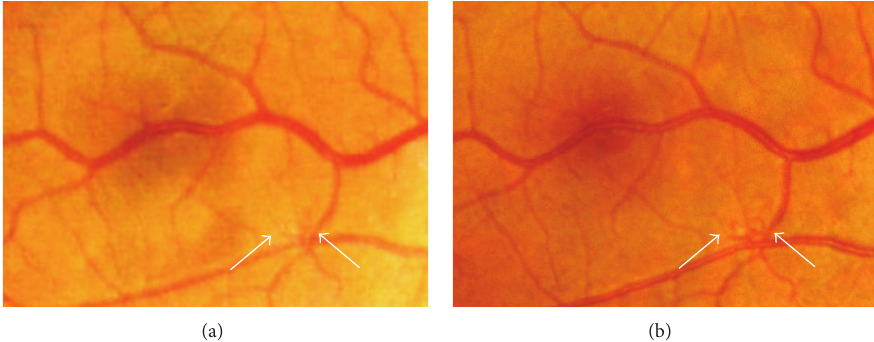
Figure 2: High-magnification images of the right fundus. Note dynamic changes to the microvascular abnormality (arrow) (b) in comparison to its appearance at the initial visit